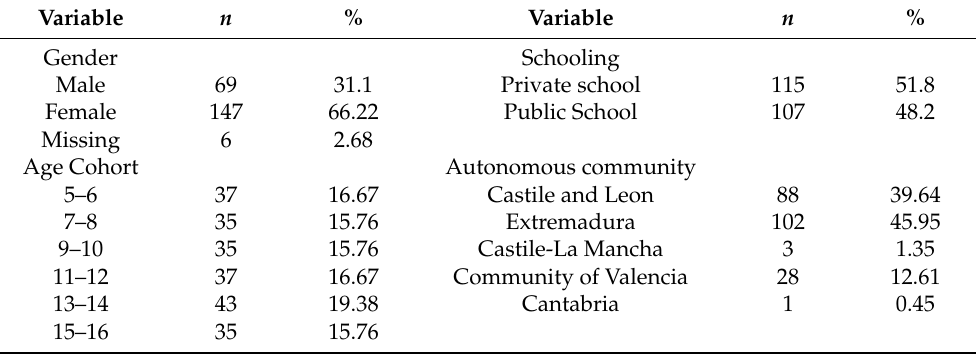
Table 1. Participants’ sociodemographic